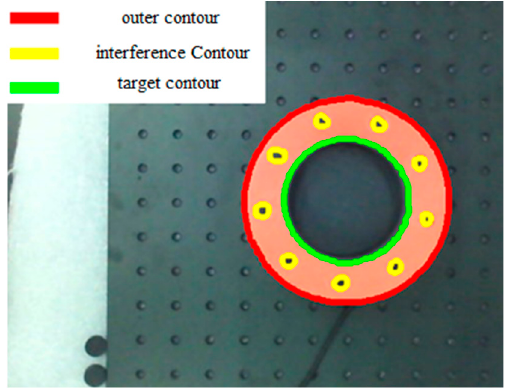
Figure 7. Final target contour diagram.